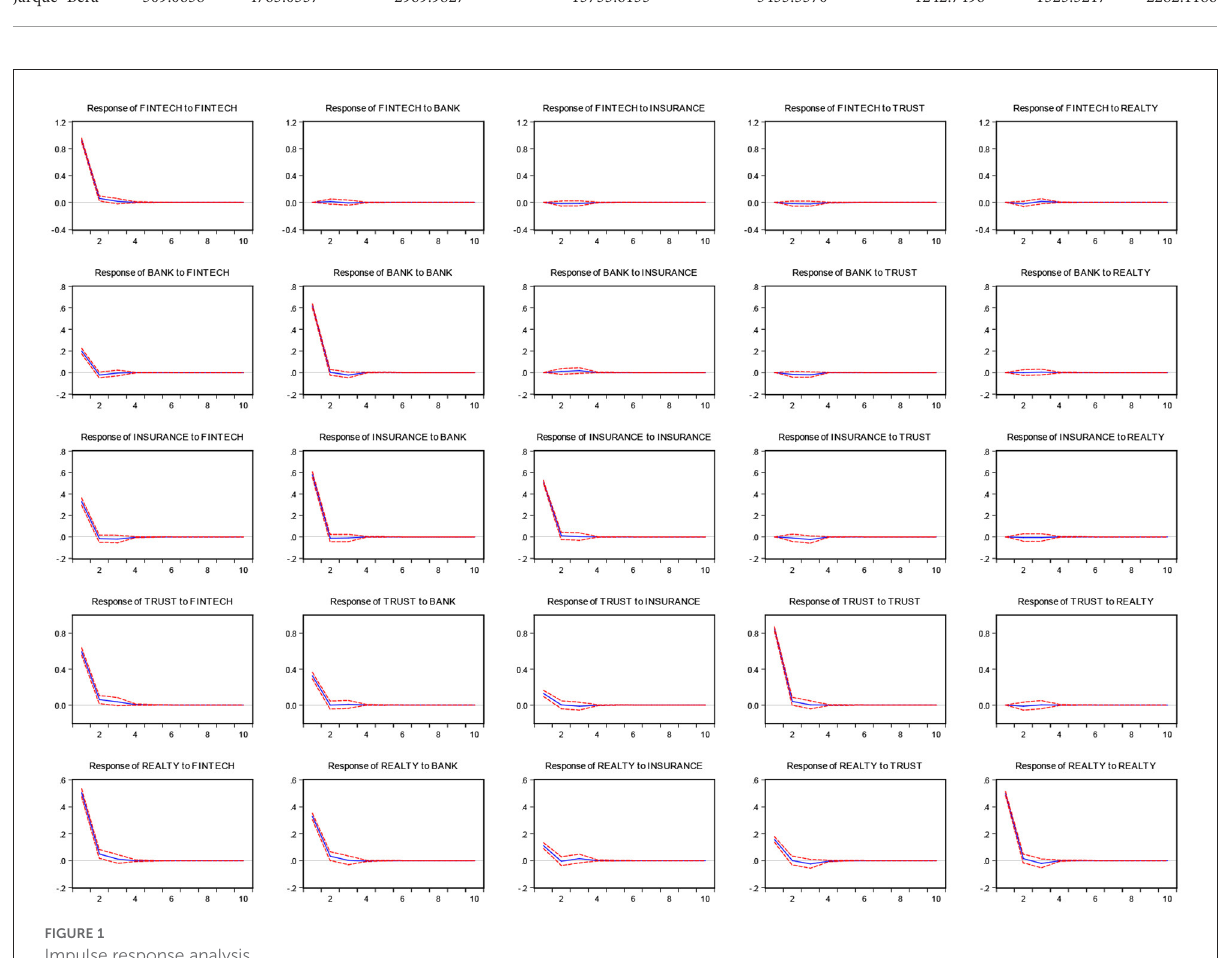
According to the method, the multivariate GARCH model can be used to not only evaluate the fluctuation aggregation characteristics of multiple time series but also effectively evaluate the correlation between different variables. Engle ( 47) proposed the DCC-GARCH model, which can be used to examine the dynamic time-varying correlation between different time series,